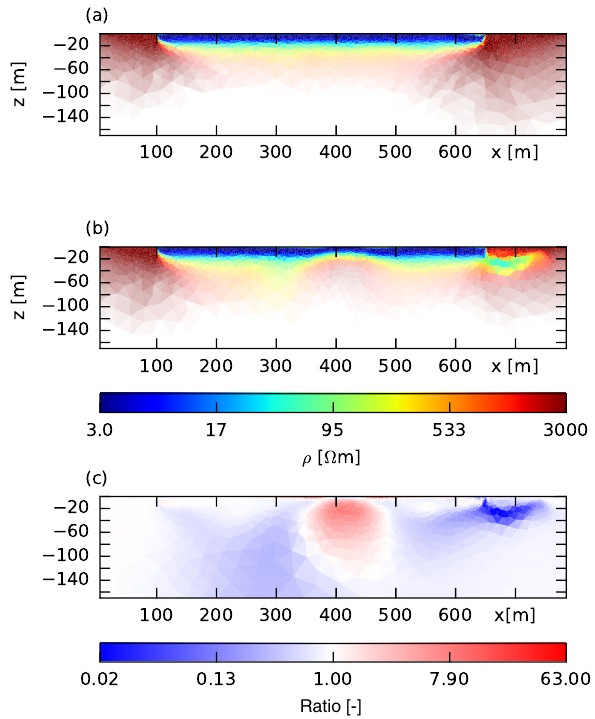
Figure 6. Inversion results of the synthetic case with (a) a pure 2-D model, (b) the incorporated island and the small bay causing 3-D effects and (c) the ratio between (a) and (b) .